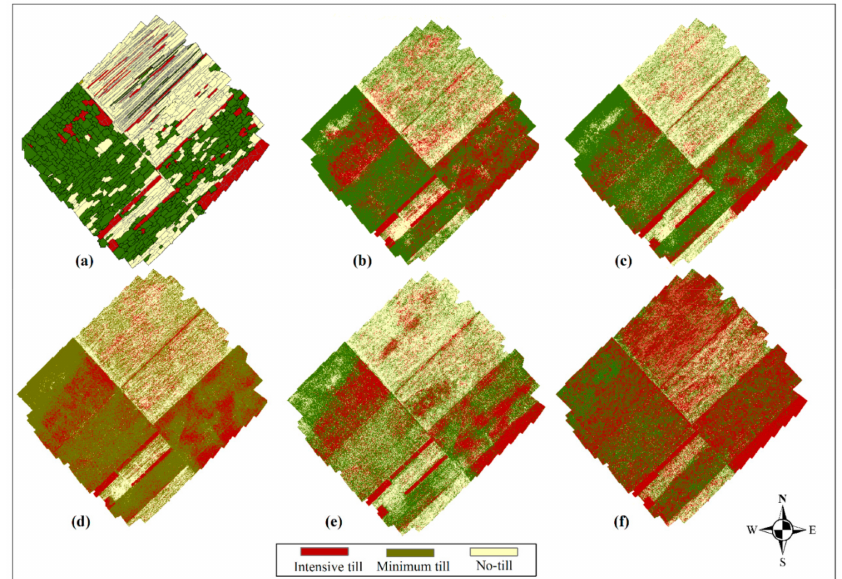
Figure 11. Classification maps of the tillage and planting practices for the digital UAV based on the images: ( a ) fuzzy OBIA, ( b ) ANN, ( c ) SVM (RBF), ( d ) SVM (polynomial), ( e ) SVM (linear), and ( f ) SVM